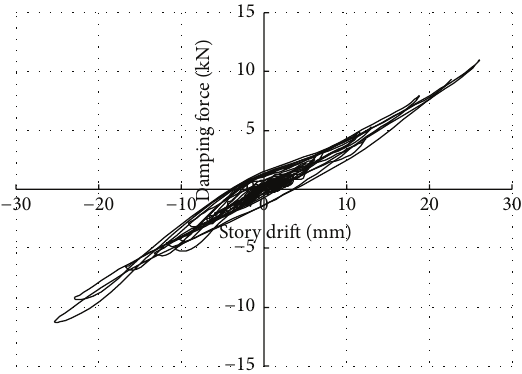
Figure 11: Hysteretic loop of interaction force of the test structure at the 1st floor with predictive control of 0.07 seconds under excitation of the Kobe earthquake with PGA = 0.912m/sec 2 (91.2gal).